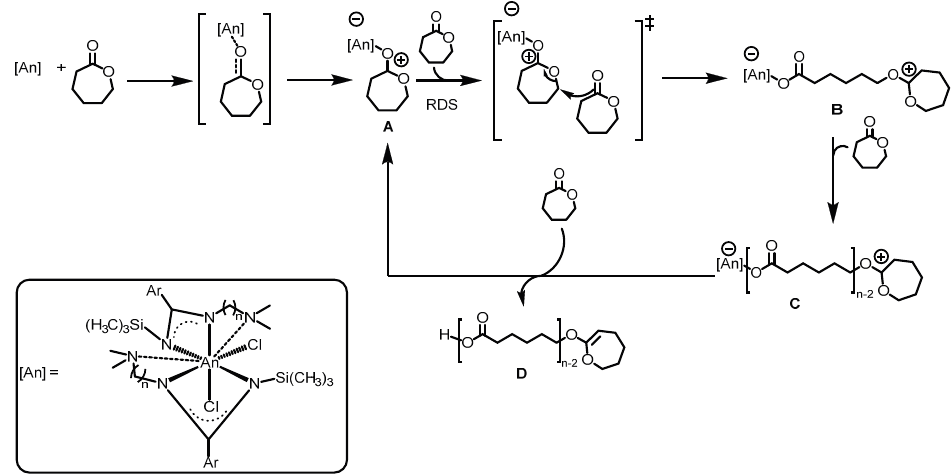
Figure 8. Actinide bis(amidinate) complexes 20 – 25 applied in the ROP of ε -caprolactone [90,91]. The mechanism for the ROP of ε -caprolactone mediated by the actinide bis(amidinate) complexes 20 – 25 is presented in Scheme 22. The respective actinide complex acts as a Lewis acid; hence none of the ligands is displaced by an ε -caprolactone monomer. Instead the monomer is activated by the Lewis acidic actinide center, generating the actinide alkoxo-caprolate intermediate A . A subsequent nucleophilic attack of an incoming monomer on complex A , gives the open chain intermediate B , which is the rate determining step of the reaction. Further insertion of ε -caprolactone units into the An–O bond of B , furnishes compound C , which after the elimination of the polymer ( D ) regenerates the active catalyst A [90,91]. Also actinide inclusion complexes have been recently shown to operate via the mechanism depicted in Scheme 22